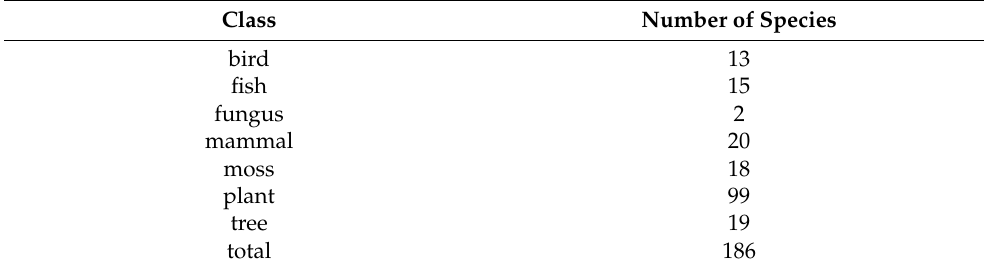
Table 1. Breakdown of species by class.